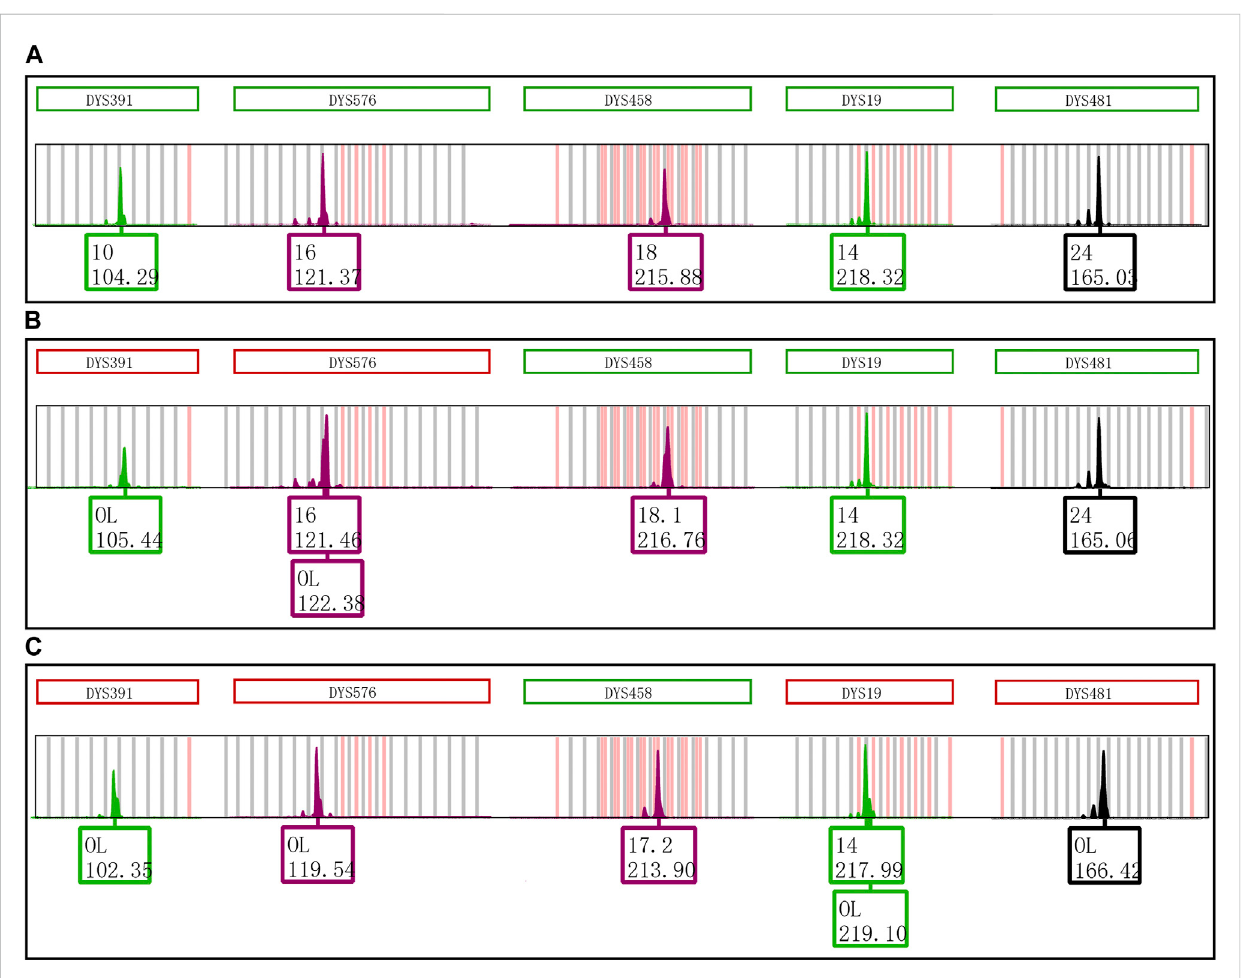
Primermodi fi cationsstronglyaffecttheEASPformation. (A) ThePCRproductsoforiginalprimersstoredat4 ° Cfor1 day.Onlyonetypicalallelicpeak with an expected peak size was observed at loci DYS391, DYS576, DYS458, DYS19 and DYS481, respectively. (B) The PCR products of original primers storedatroomtemperaturefor1day.TheextrapeaksappearedatlociDYS391,DYS576 andDYS458,butnotobservedatDYS19andDYS481loci. (C) The PCR products of revised primers stored at room temperature for 1 day. The reverse primers of loci DYS391, DYS576, DYS458, DYS19 and DYS481 were revised as described in Table 1. The phenomenon observed in Figure 5C is opposite to that of observed in Figure 5B. The extra peaks appeared at loci DYS19 and DYS481, but not observed at loci DYS391, DYS576 and